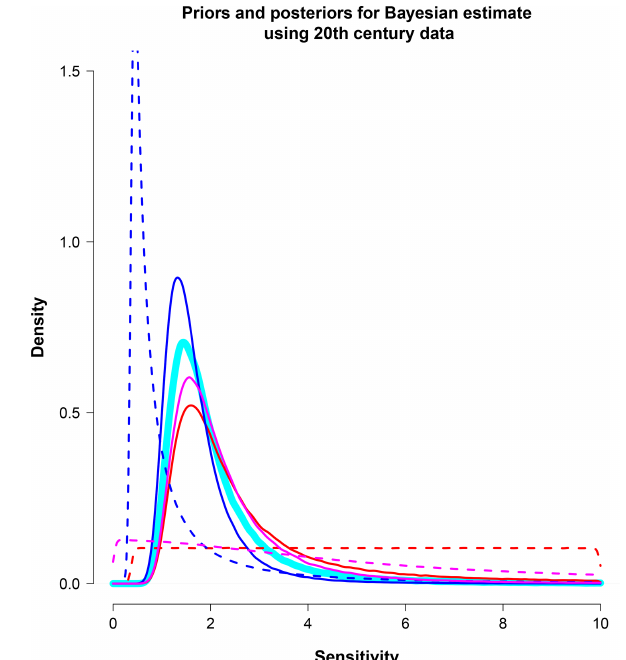
Figure 5. Priors and posteriors over S in a process-based feedback analysis. Dashed lines indicate priors, and solid lines are posteriors. The thick cyan line shows the posterior estimate arising from the method of sampling observational PDFs, which coincides precisely with the blue line that corresponds to the uniform prior in λ . Red lines show results using a uniform prior in S , and magenta is half- Cauchy (scale: 5) in S